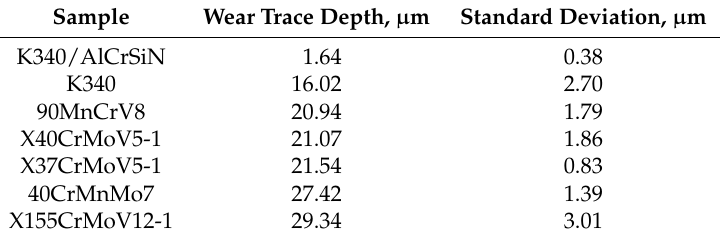
Table 7. Comparison of wear trace depths obtained for the tested